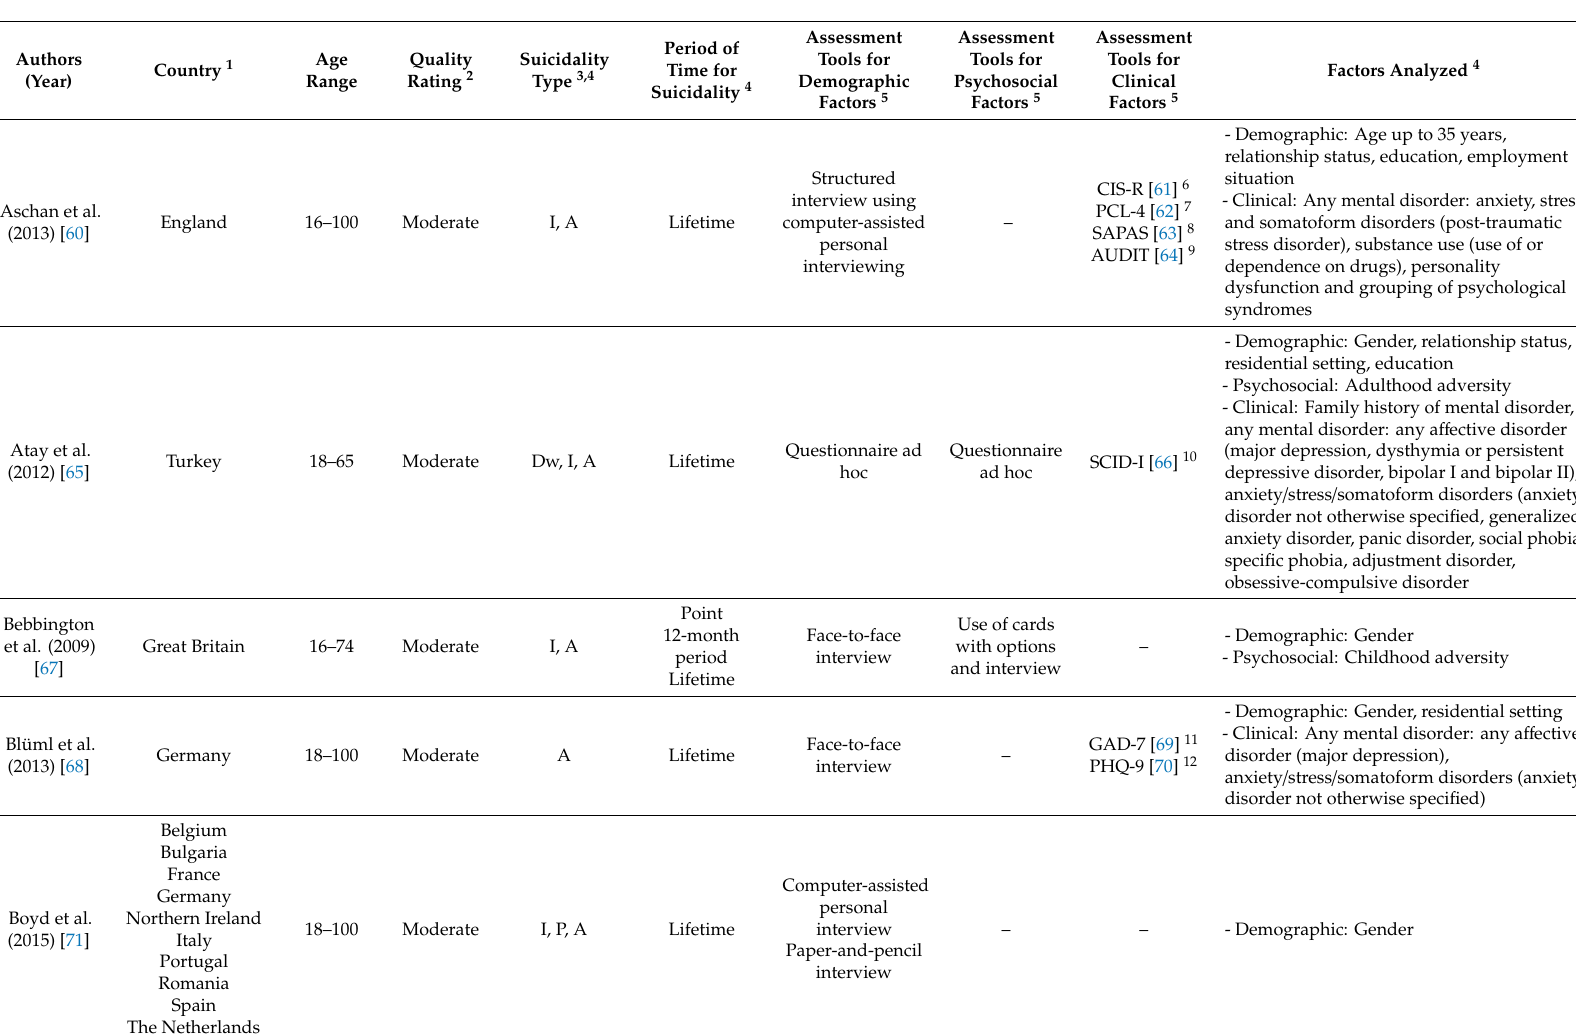
Table 1. Characteristics and outcome information of included